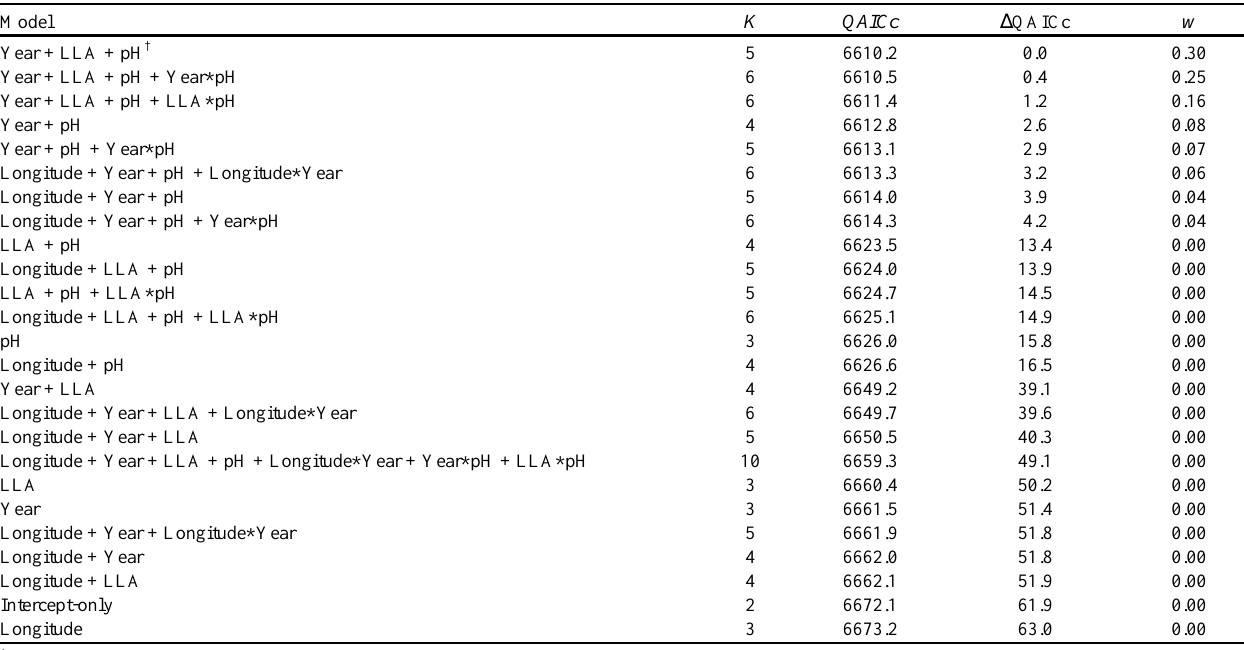
Table 3 . Model selection results for 25 candidate models explaining patterns in Common Loon ( Gavia immer ) reproductive success as a function of longitude, year, lake area, and pH across southern Canada between 1992 and 2010. K = number of parameters; QAICc = quasiliklihood Akaike’s information criterion; w = Akaike weight; LLA = log lake area. Parameter estimates with 95% confidence limits (lower, upper) are shown below for the best model; model-averaged estimates are given in Table 2.